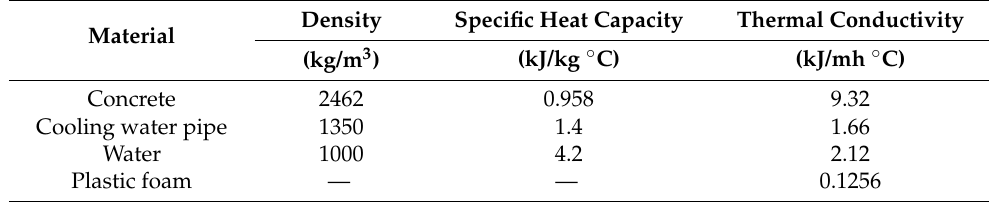
Figure 3. Layout simulation diagram of cooling water pipes poured by stages in an aqueduct. ( a ) Overall model of aqueduct ( b ) The first stage of concrete pouring water pipe arrangement ( c ) The second stage of concrete pouring water pipe arrangement ( d ) water pipe simulation element. Table 3. Material